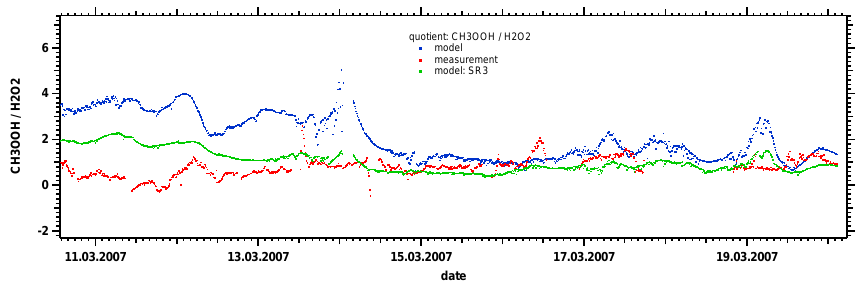
Figure 6. Simulated (blue) and observed (red) CH 3 OOH-to-H 2 O 2 ratio. The green line shows a sensitivity simulation (SR3) including reduced H 2 O 2 dry deposition velocity and the reaction of CH 3 O 2 with OH (see text for